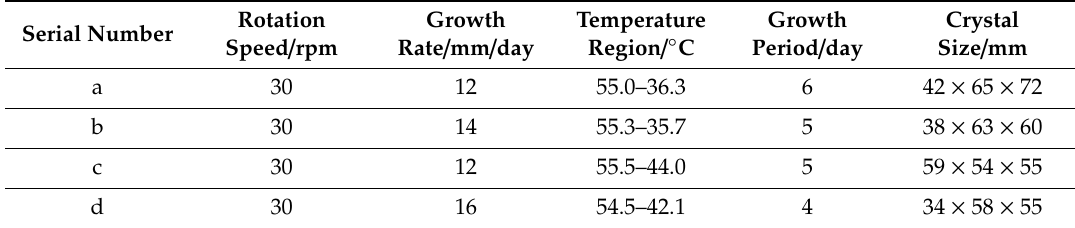
Table 1. Growth parameters of KDP crystals.